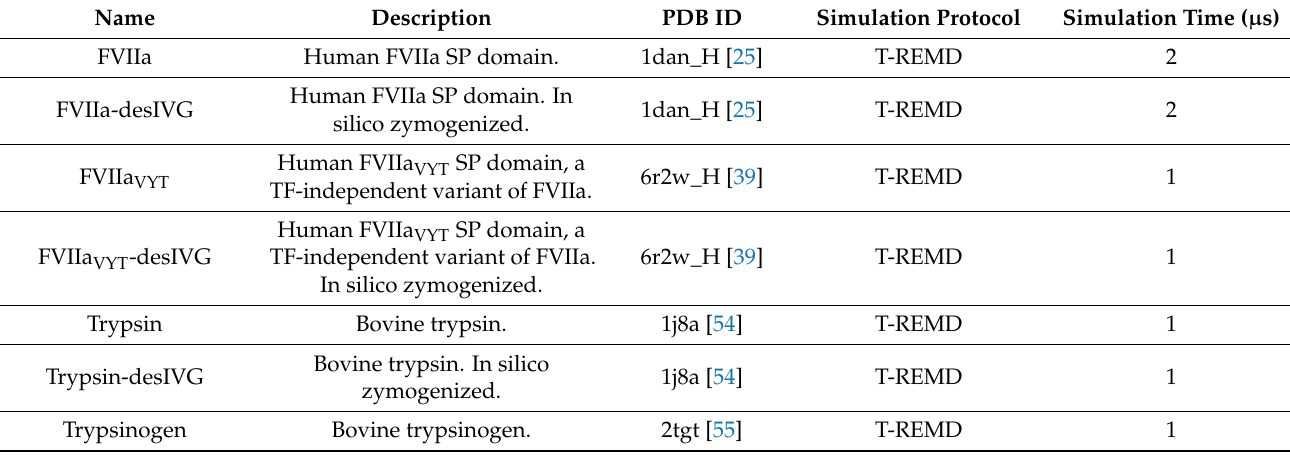
Table 1. Summary of the structures used, and the systems simulated in this